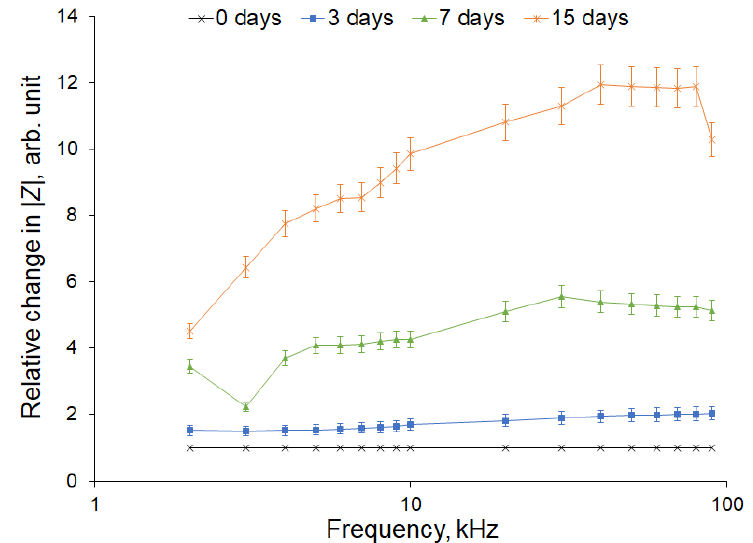
Figure 11. Relative change in the impedance modulus during the drying of apple tree branches for 3, 7, and 15 days. The number of samples was 10 and the number of measurement repetitions was 5. Data are presented as mean values and standard errors.